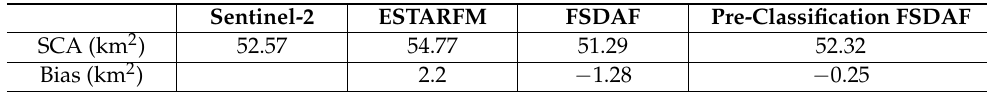
Table 3. SCA Estimated from the actual NDSI S2 and the NDSI predicted by the three fusion models and their Bias.